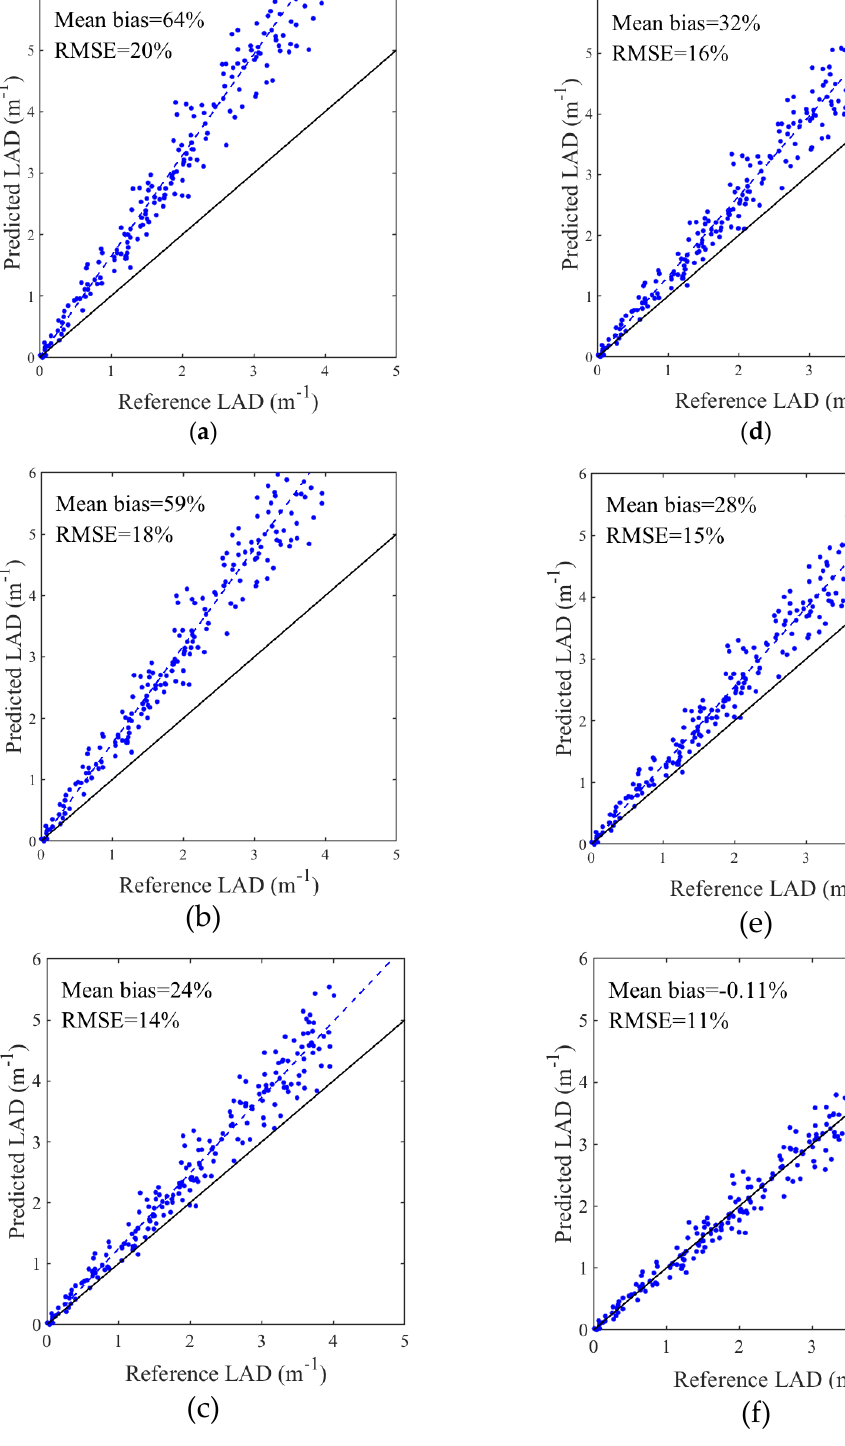
Figure 4. Comparison between predicted and reference LAD for a variety of formulations to account for wood in estimators (see Table 1 for details): ( a ) Equation (7); ( b ) Equation (8); ( c ) Equation (15), (with 𝛼 = 1 , Ni 𝑙 >>1, and 𝜆 1 ≪ 1 ); ( d ) Equation (7), with 𝛼 multiplicative factor; ( e ) Equation (8), with 𝛼 multiplicative factor; ( f ) Equation (15) ( Ni 𝑙 >>1 and 𝜆 1 ≪ 1 ). Formulations presented in subplots (a–c) ignored wood volumes, contrary to subplots (d–f).